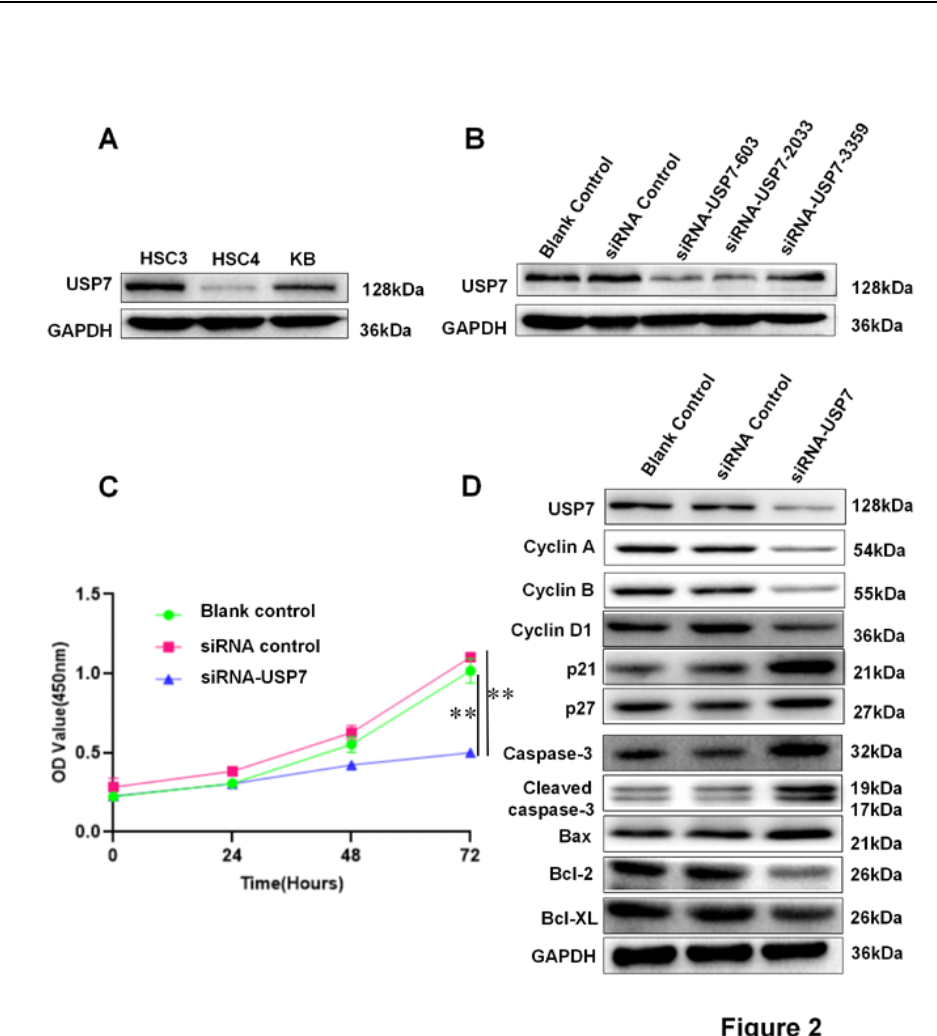
Figure 2 – USP7 promotes OSCC cell proliferation by affecting cell cycle-related and apoptosis-related proteins. A. Western blot was used to detect the expression level of USP7 in HSC3, HSC-4, and KB cells. GAPDH was used as control. B. USP7 expression in HSC3 cell that was transfected with USP7 siRNA or siRNA negative control, and blank control. GAPDH was used as house-keeping control. C. Growth curve for HSC3 cells with siUSP7 treatment. Forty-eight hours after USP7 siRNA treatment, 1000 cells were seeded onto 96-well plate. Cell number at 24 h was set as 0 h. Cell numbers were continuously counted at 24 h, 48 h, 72 h. ** P<0.01 . D. HSC3 cells were transfected with USP7 siRNA. Cell cycle-related and apoptosis-related genes were examined by WB at 48